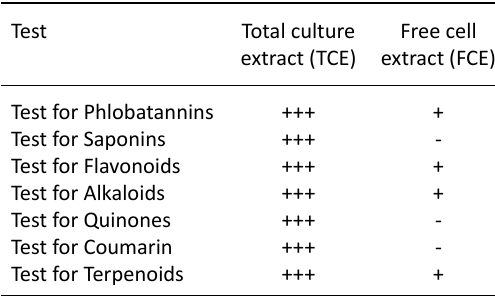
Table 3. Quantitive phytochemical screening of